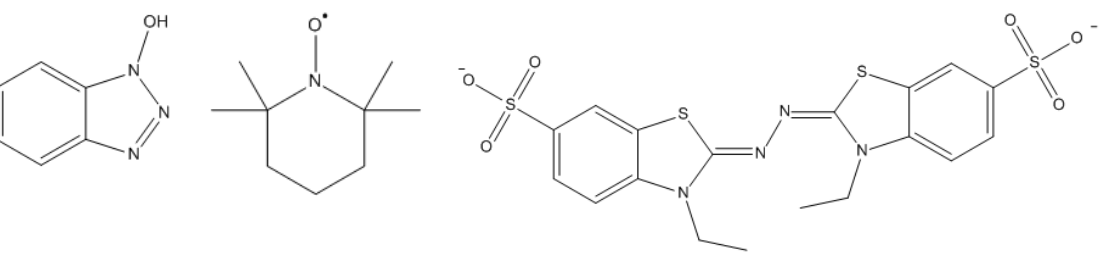
Figure 3. Chemical structures of the mediators